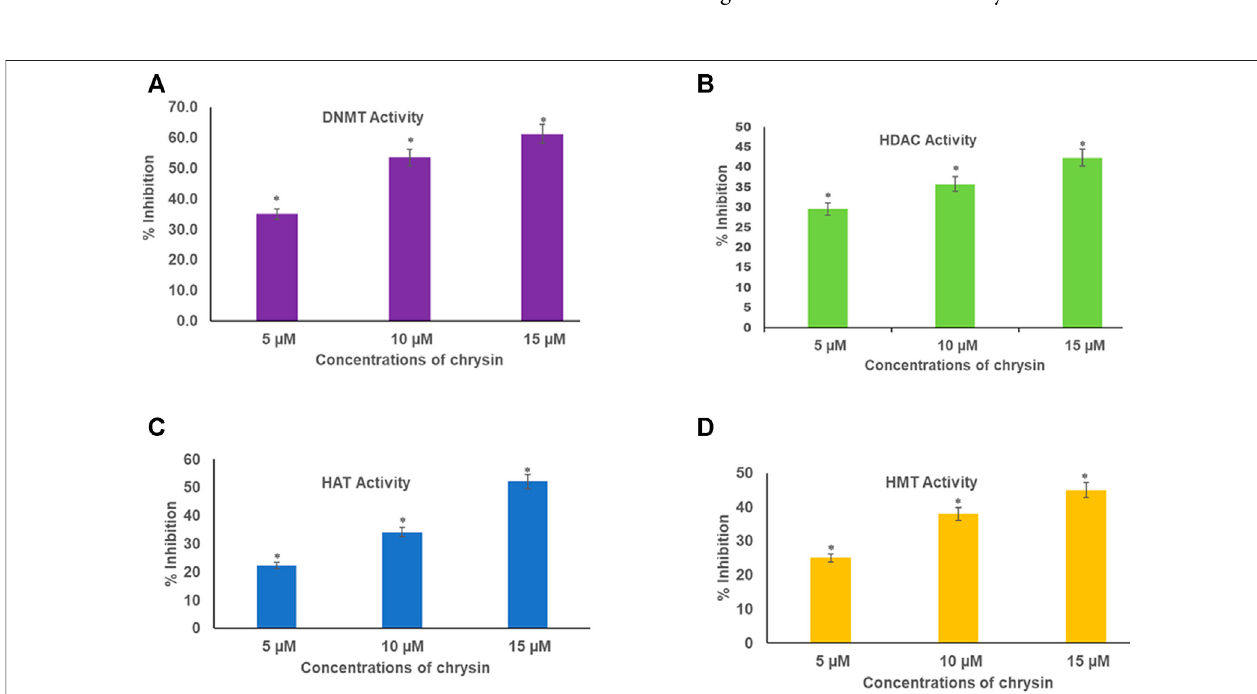
FIGURE 4 | (A) Chrysin decreased DNMT activity in HeLa cells irrespective of their location on the genome in a concentration-dependent manner. (B) Chrysin inhibitedHDACactivityinHeLacellsinaconcentration-dependentmanner.Theactivitydecreasedwithincreaseinthedoseofchrysin (C) Chrysindecreasedtheactivity of HAT in a dose-dependent manner. As the concentration of chrysin increased, the inhibition percentage increased. (D) Chrysin decreased HMT H3K9 enzyme activity in HeLa cells, irrespective of their location on the genome in a concentration-dependent way.